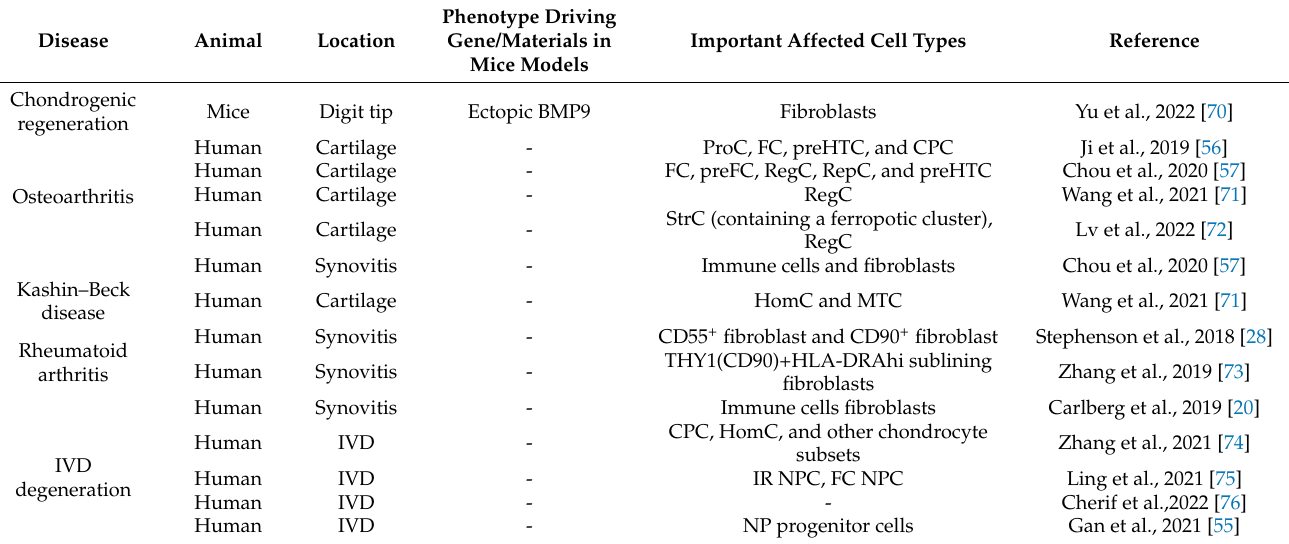
Table 3. Application of single-cell and spatial omics to decode cartilage or joint-related